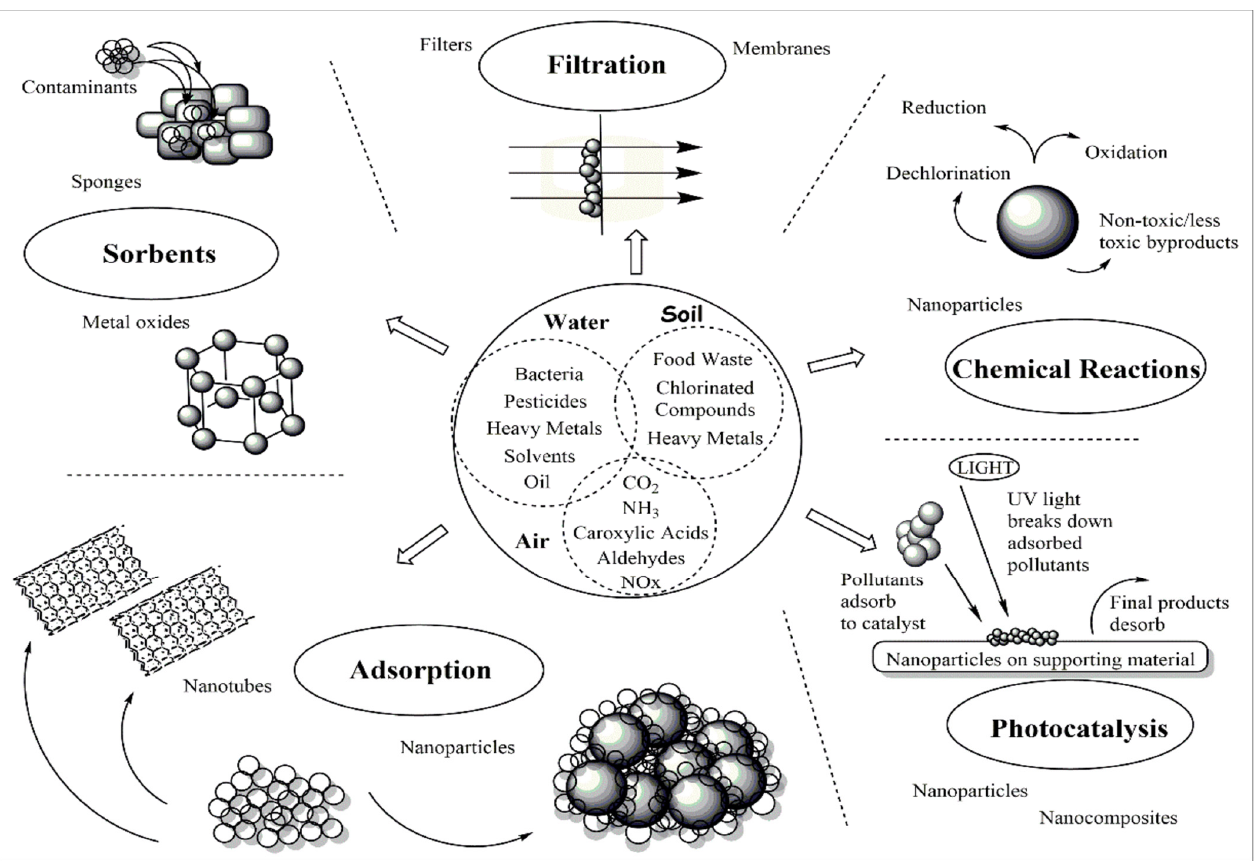
Figure 1. General overview of environmental remediation approaches with the use of nanotechnology.